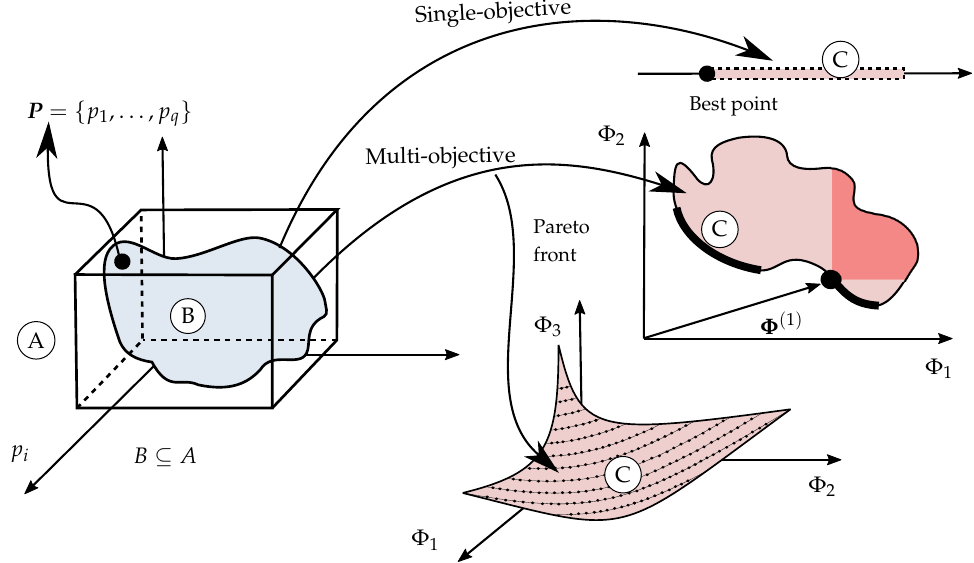
Figure 5. A scheme for a graphical representation of the optimization problem in terms of: ( A ) pa- rameters space in Equation (7); ( B ) feasible space in Equations (5)–(9); and ( C ) objective space in Equation